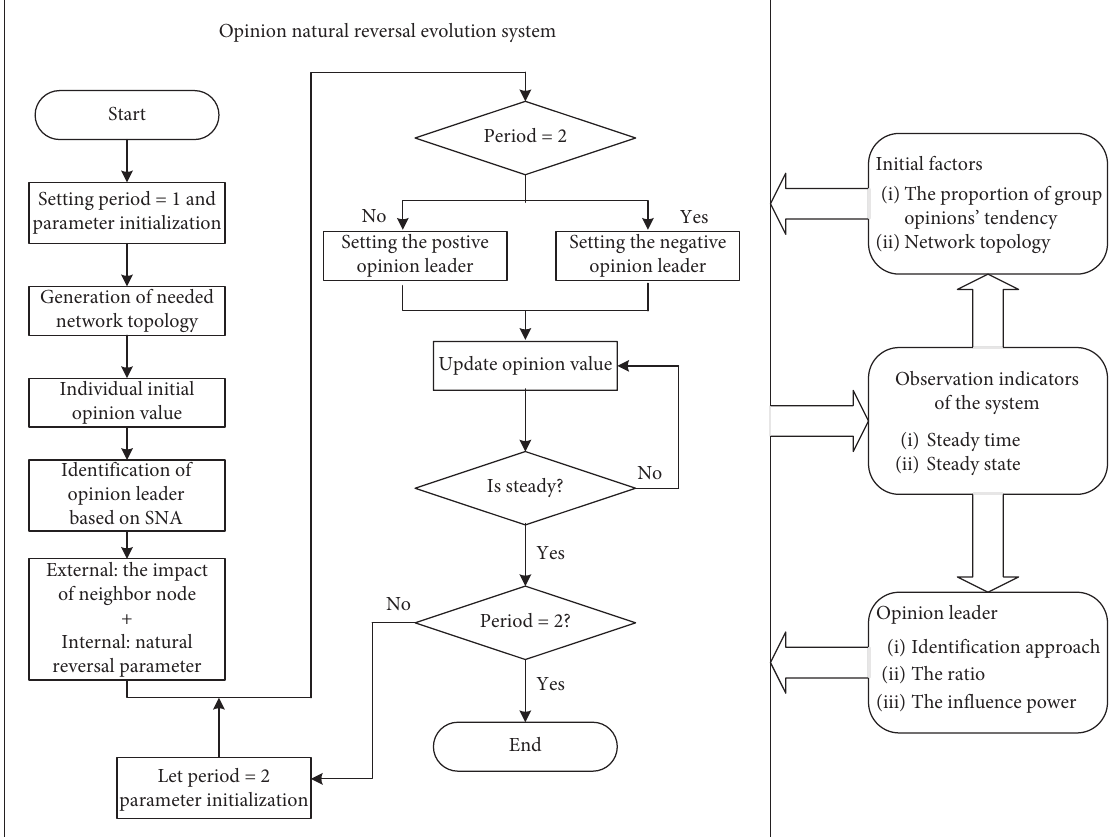
Figure 1: Algorithm process of the simulation experiment